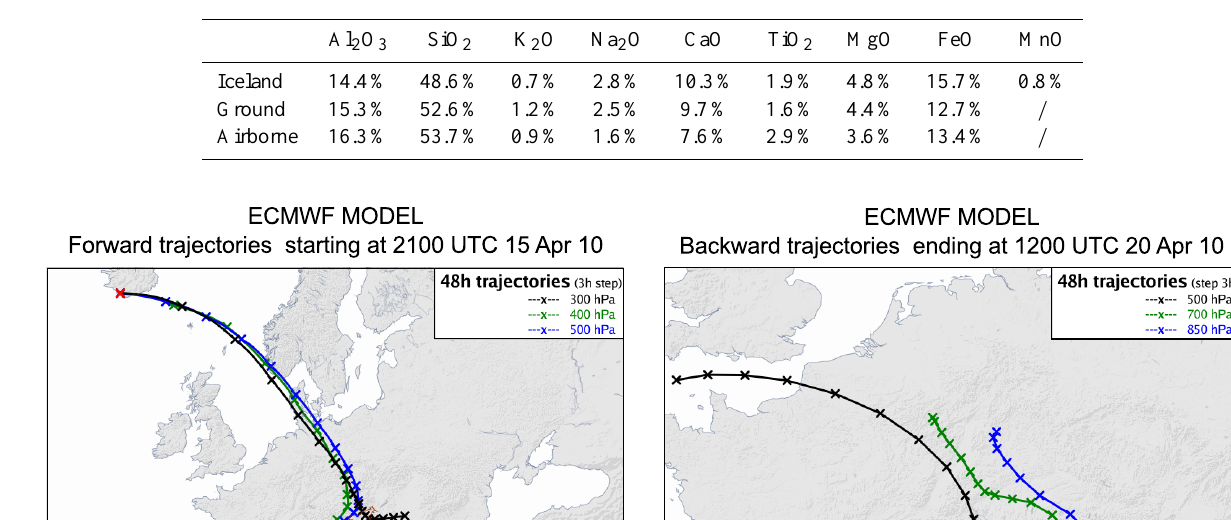
Table 3. Comparison of the chemical composition between representative particles from the reference ash samples collected in Iceland and ash candidates from the aerosol samples collected in Slovenia.